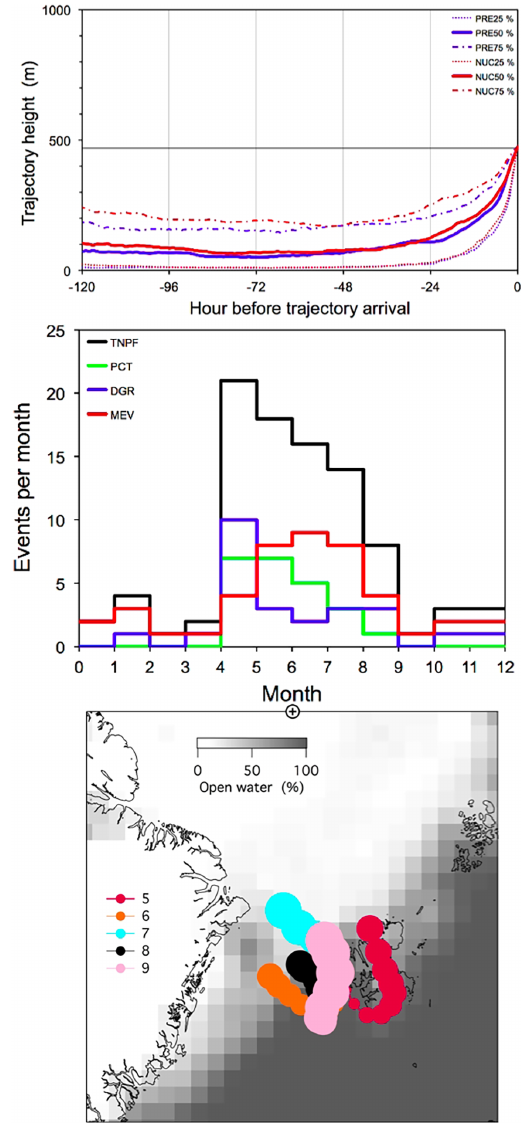
Figure 9. Characteristics of the sub-population of 93 NPF events with back trajectories that stayed below 500m for 5 days before arrival. Top: statistics of related vertical trajectory coordinates as in Fig. 5. Center: average monthly occurrence of PCT, DGR, and MEV events, summed up over the whole period of 10 years. Bot- tom: related average monthly trajectory positions in 12h steps for the months May through September. The circles comprise 95% of all trajectories at any trajectory step. The underlying grayscale map indicates July ice cover averaged over